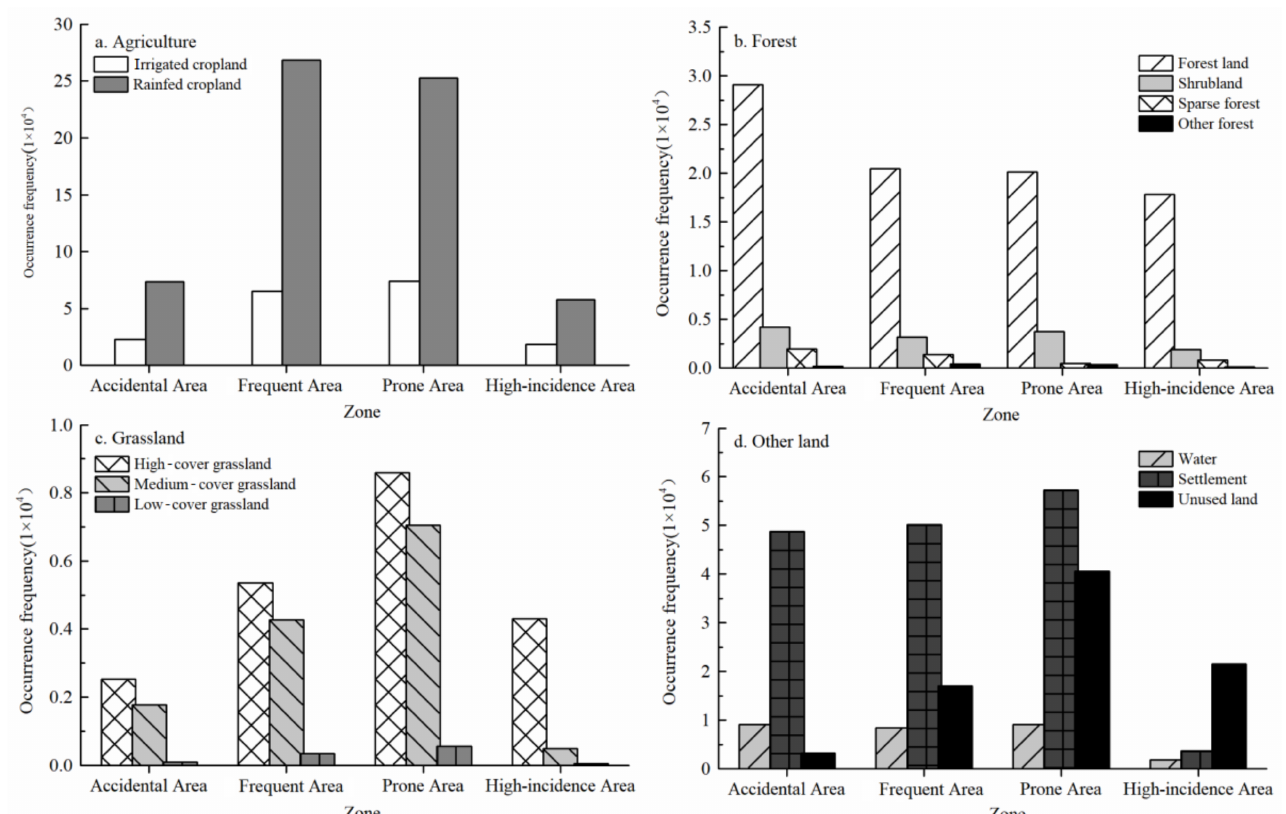
Figure 7. Occurrence characteristics of land cover in active fire-hazardous areas in Northeast China. Note: ( a ) Cropland, ( b ) Forest, ( c ) Grassland and ( d ) other land